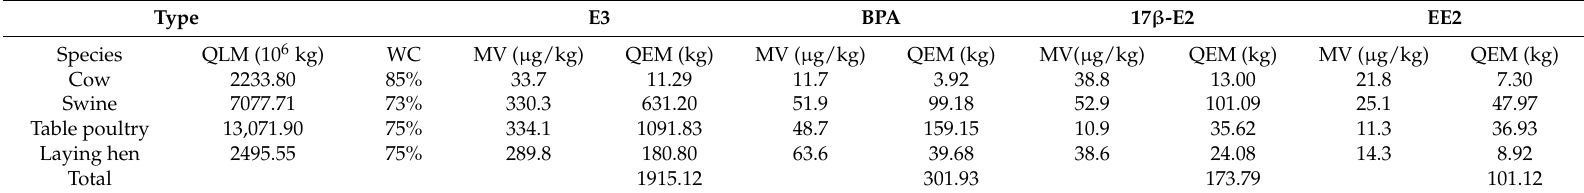
Table 5. The quantity of estrogens in livestock manure in 2014 in Jiangsu Province, China.